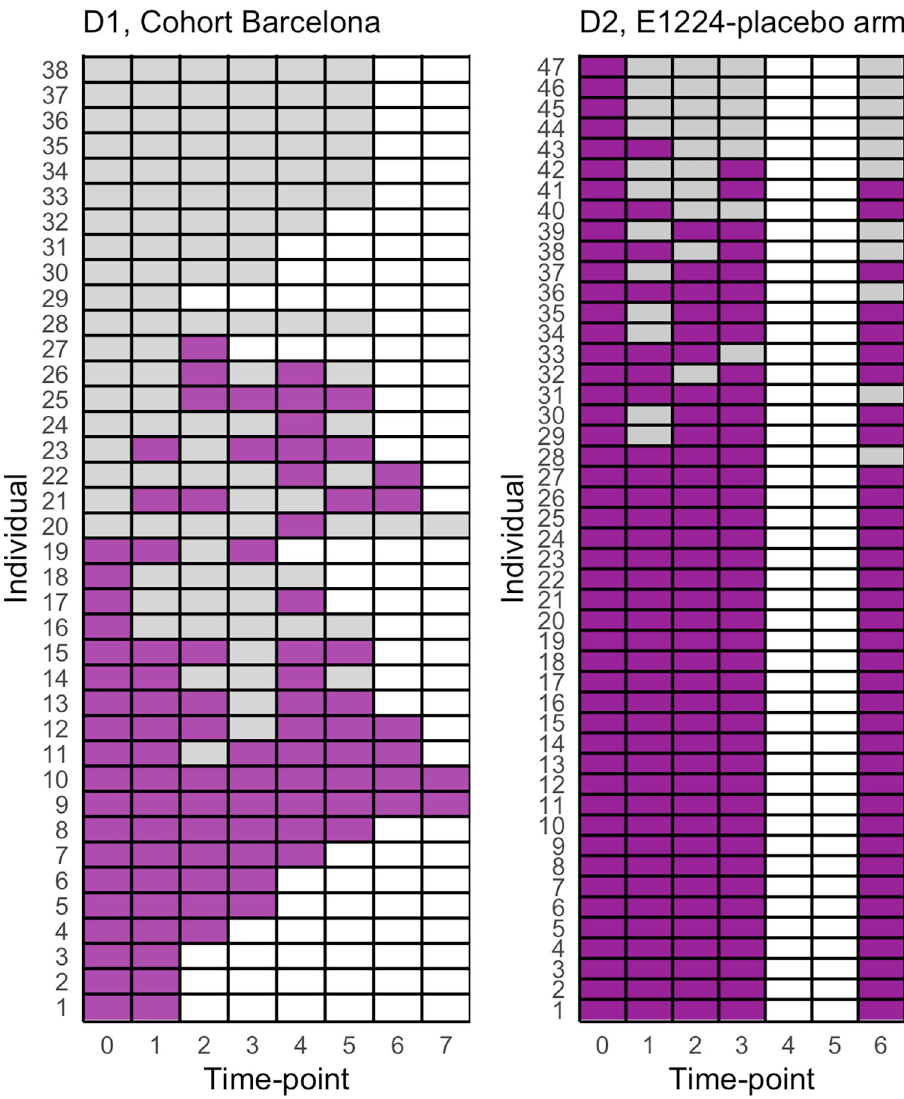
Fig 1. Qualitative parasite detection series by individual and dataset. Showing parasitemia at each time point per individual (as PCR positive in purple, or PCR negative in gray) for individuals in D1 (left panel) and D2 (right panel). White cells represent unavailable